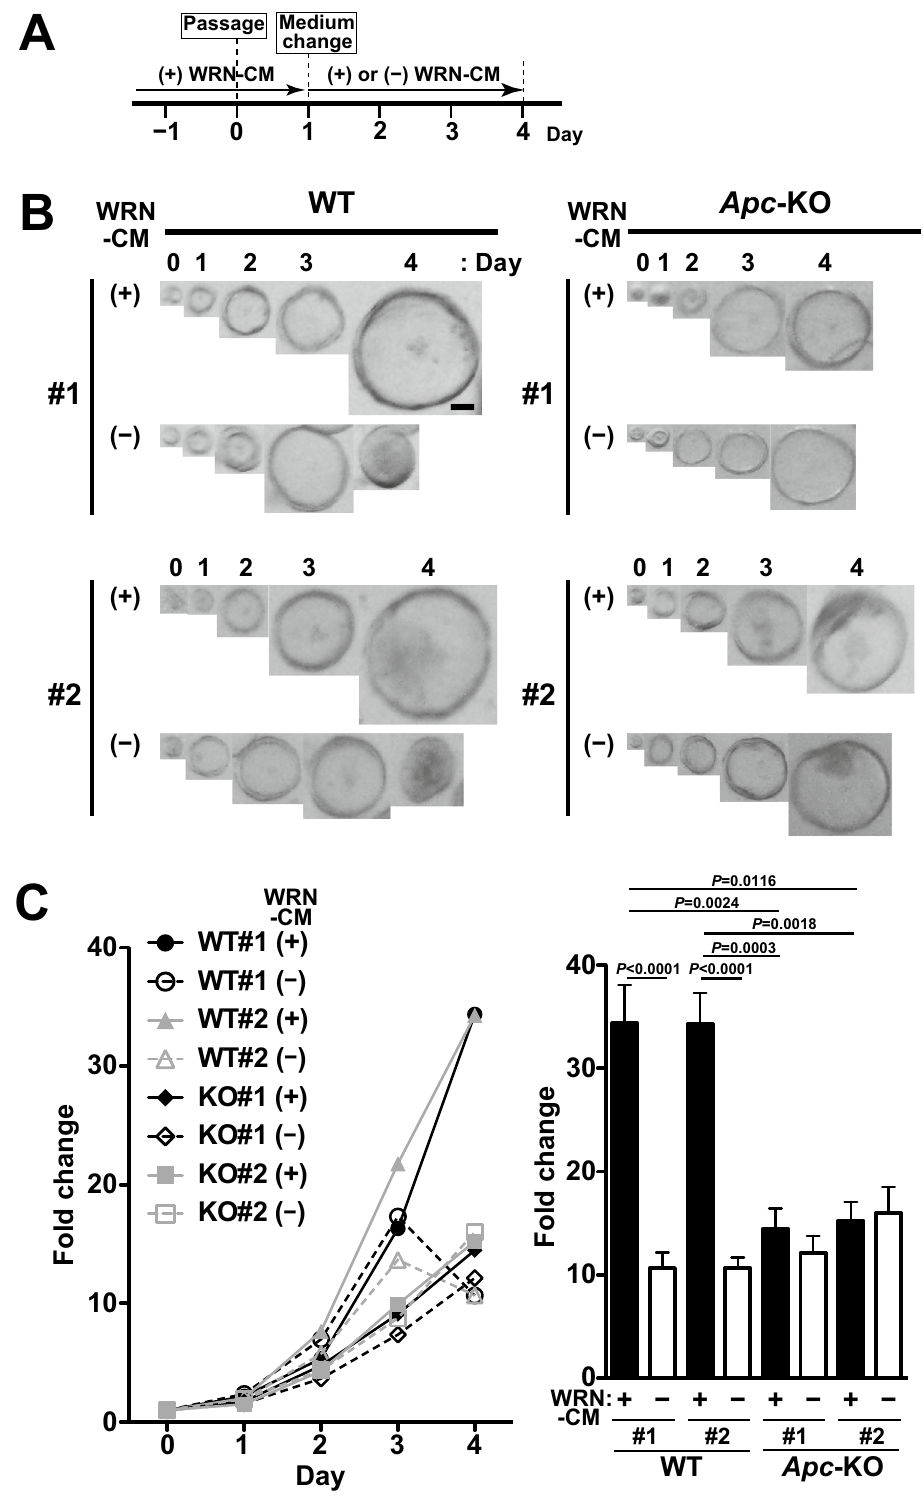
Figure 2. Growing properties of Apc -KO organoids. ( A ) Experimental schedule. Colonic organoids were passaged on Day 0, and then cultured in the presence of WRN-CM to facilitate organoid formation. The medium was changed to the fresh medium supplemented with (+) or without (−) WRN-CM on Day 1, and then the organoids were cultured for 3 more days (Days 2–4). ( B ) Time course of development of an organoid. Scale bar, 50 μm. ( C ) The growth rate of organoids was determined by measuring the projected area of the organoid normalized to the initial size. The growth rate of each organoid on Day 4 is also plotted (right). Data are expressed as mean ± s.e.m. (n = 24 organoids for each group). Dunn’s multiple comparison test was used after Kruskal–Wallis test to calculate P